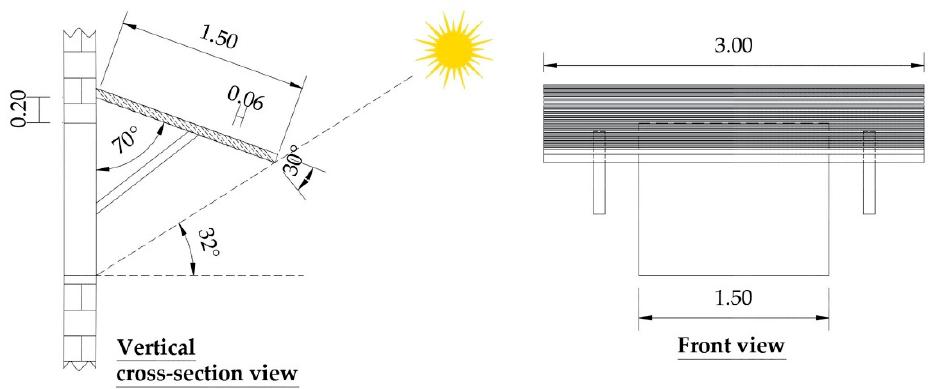
Figure 6. Typical dimensioning and positioning of horizontal overhangs for adequate indoor space shading from the 10th of May until the 20th of September for geographical latitudes at 35°.